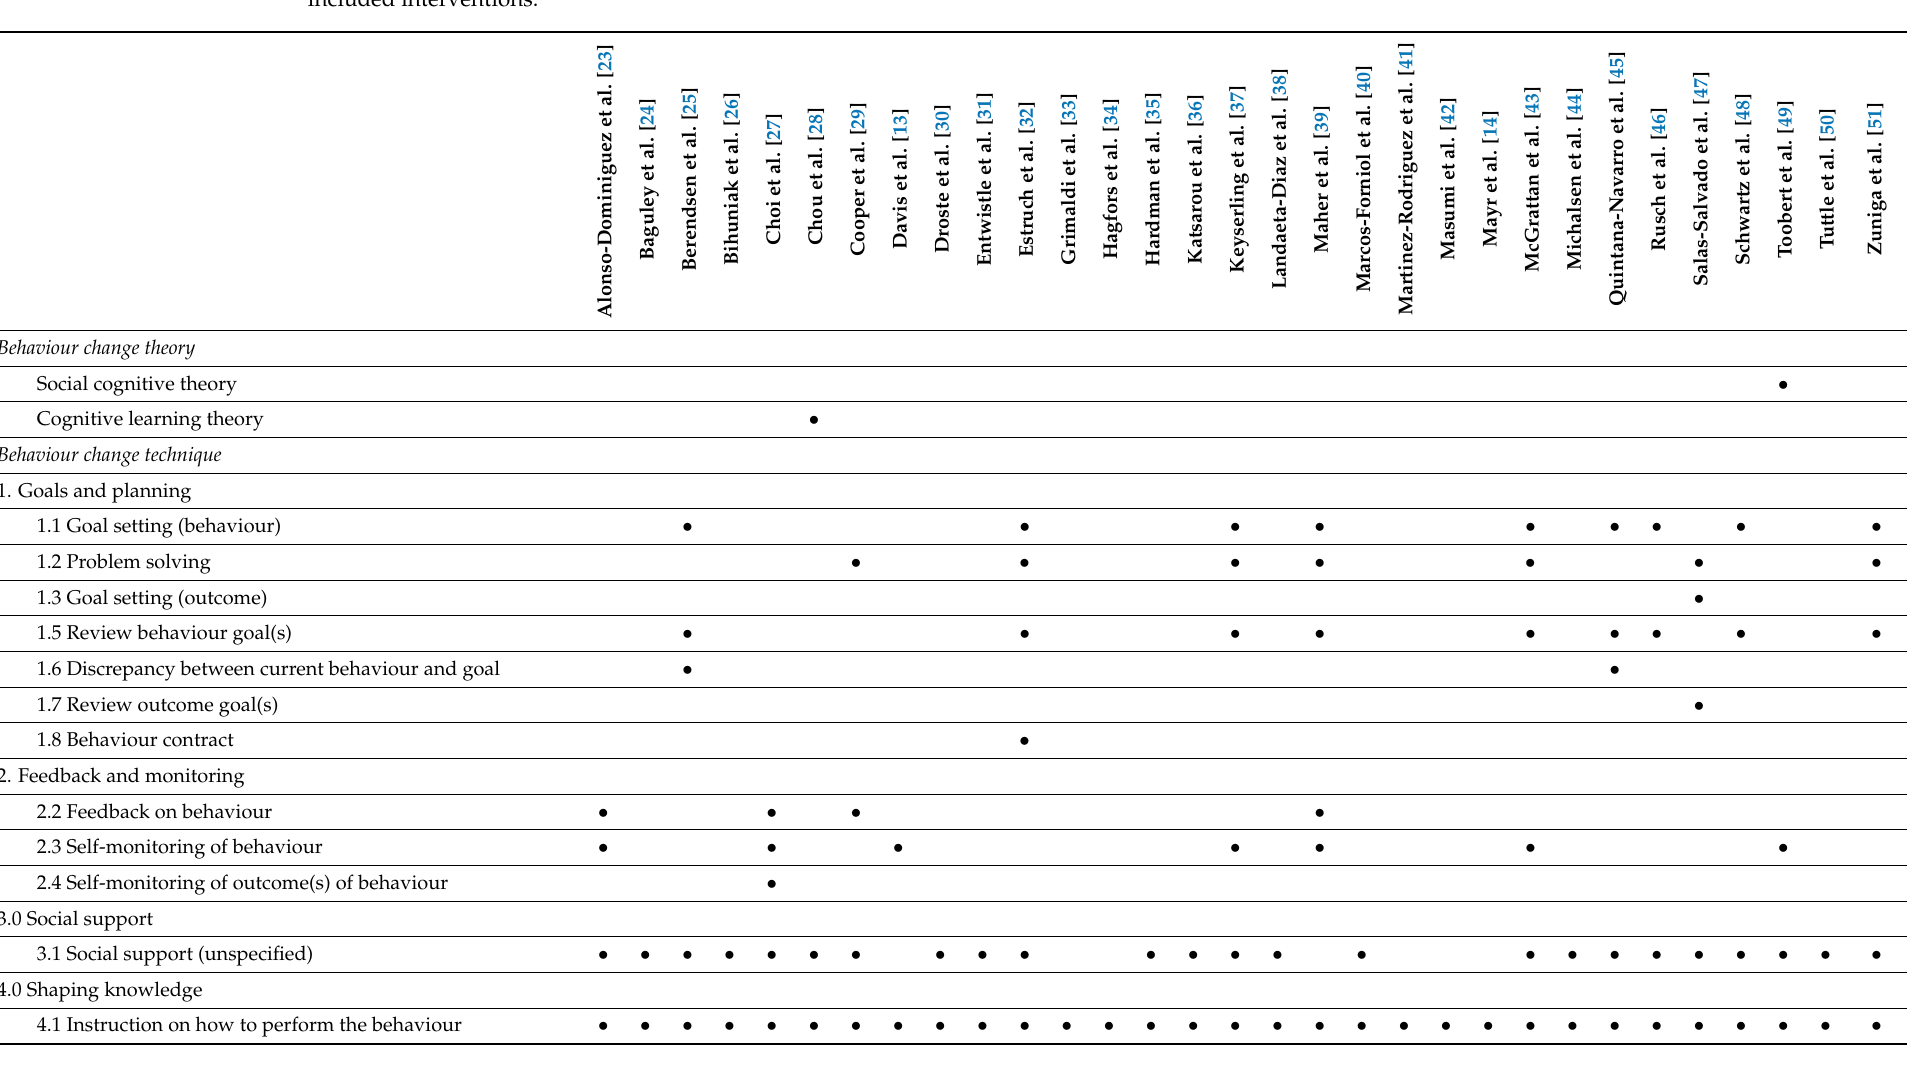
Table 3. Reported behaviour change theories and behaviour change techniques according to the Behaviour Change Technique Taxonomy (version 1) [16] in the included